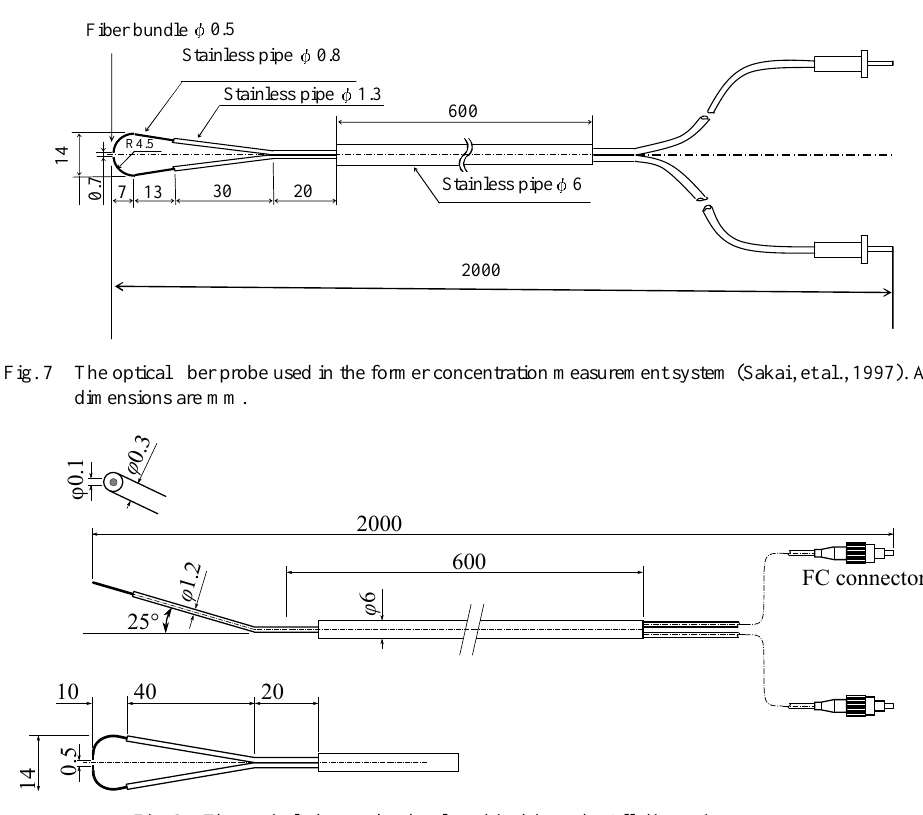
Fig. 8 The optical fiber probe developed in this study. All dimensions are